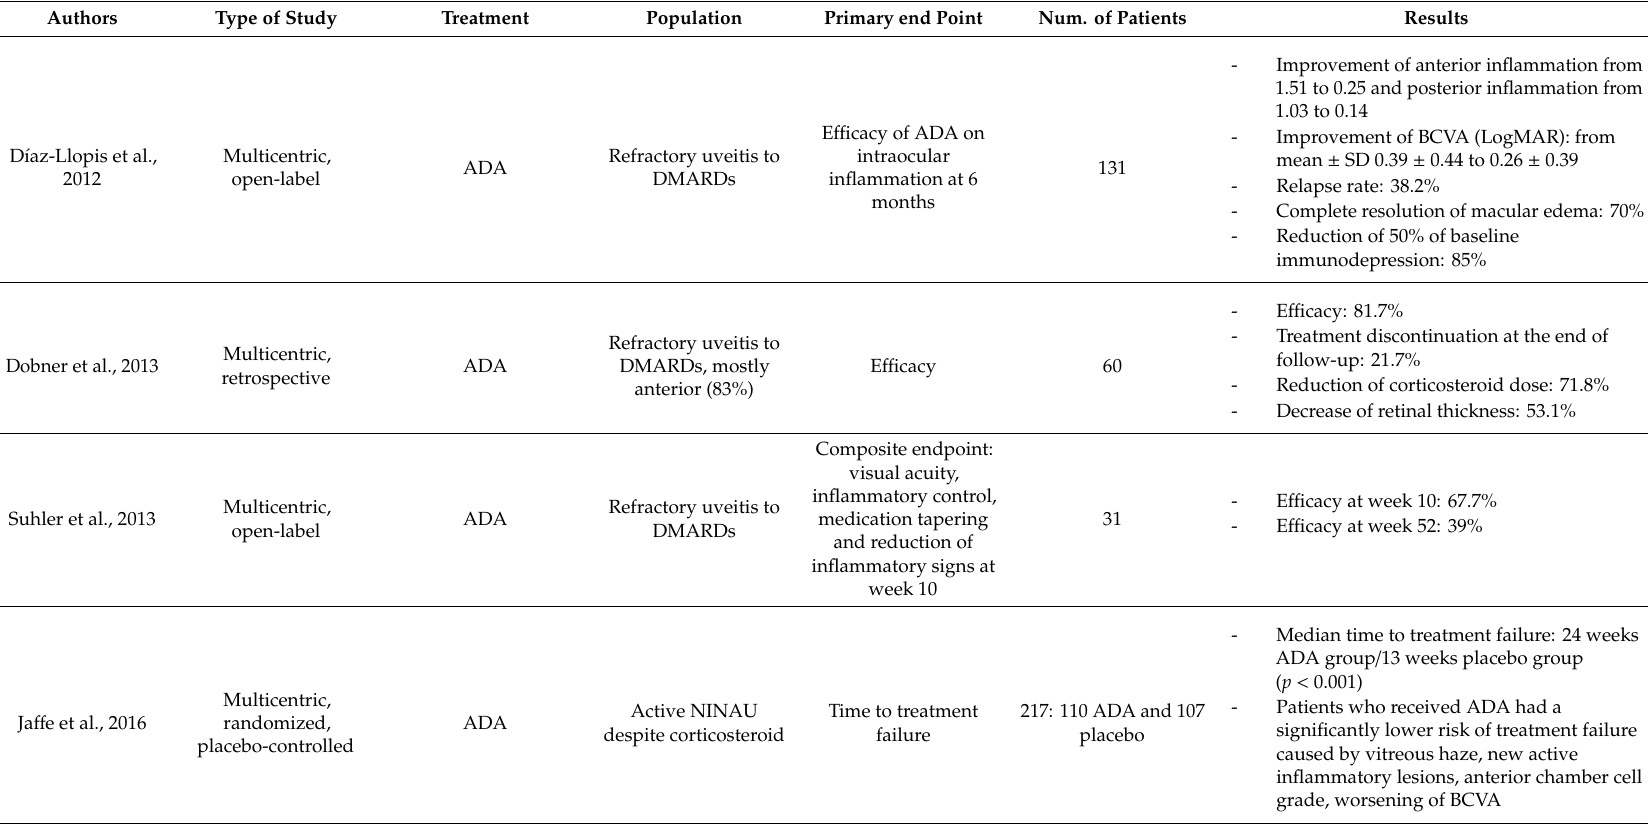
Table 1. Literature review: mains data on e ffi cacy of anti-TNF- α agents in non-infectious